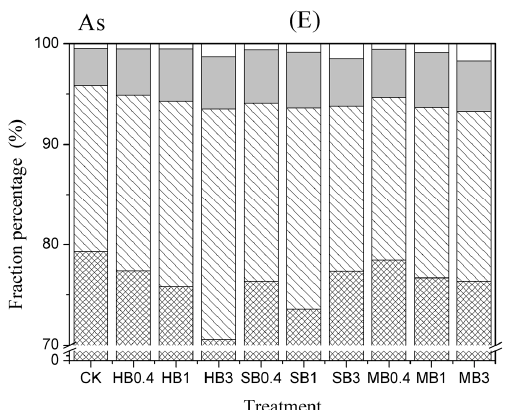
Figure 3. Effects of HB, SB and MB treatments on chemical fractionation of ( A ) Pb, ( B ) Zn, ( C ) Cu, ( D ) Cd and ( E ) As in mine tailings ( n = 3). CK, HB/SB/MB0.4, HB/SB/MB1 and HB/SB/MB3 refer to no biochar input and the incorporation of biochar into the soil at 0.4%, 1% and 3% by mass, respectively. HB: Hibiscus cannabinus core biochar; SB: sewage sludge biochar; MB:chicken manure biochar.